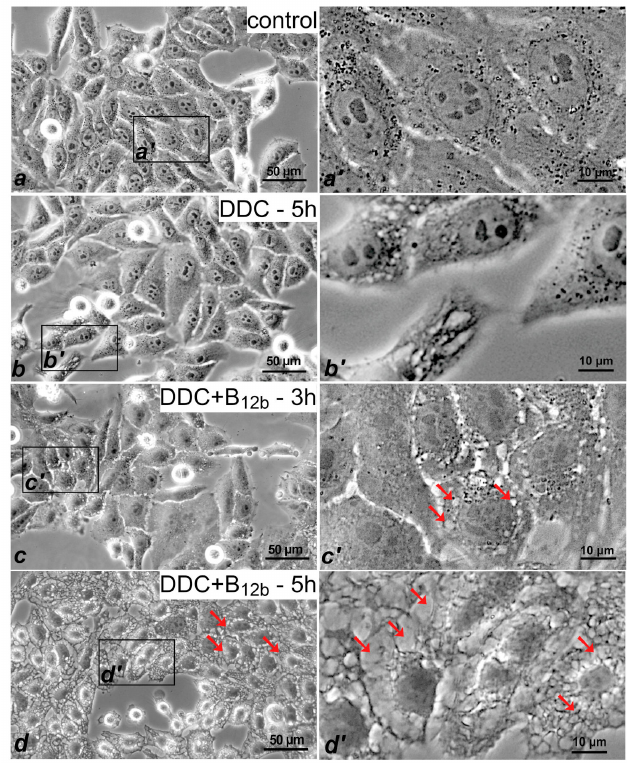
Figure 2. Vacuolization of HEp-2 cells at the stage of death initiation by the combination of 1 mM DDC + 25 µ M B 12b . ( a ) Control ( b ) after 5 h-incubation of cells with 1 mM DDC; ( c ) and ( d ) after 3- and 5-h incubations with DDC + B 12b . The arrows point to vacuoles in cells treated with DDC + B 12b . Phase contrast microscopy. ( a’ ), ( b’ ), ( c’ ), and ( d’ ):selected areas enlarged in inserts ( a ), ( b ), ( c ), and ( d